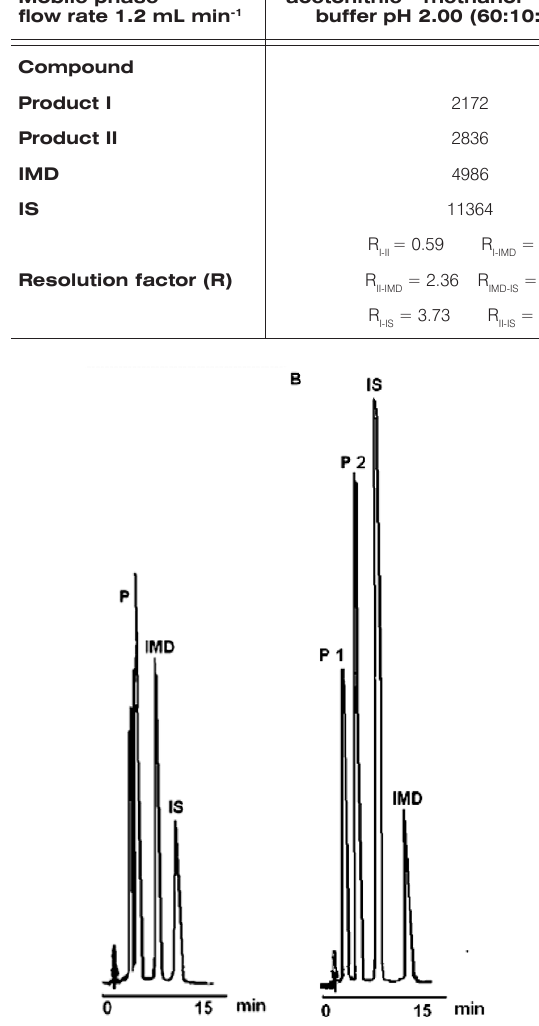
Table 1. Parameters of RP-HPLC separation efficiency. Mobile phase flow rate 1.2 mL min